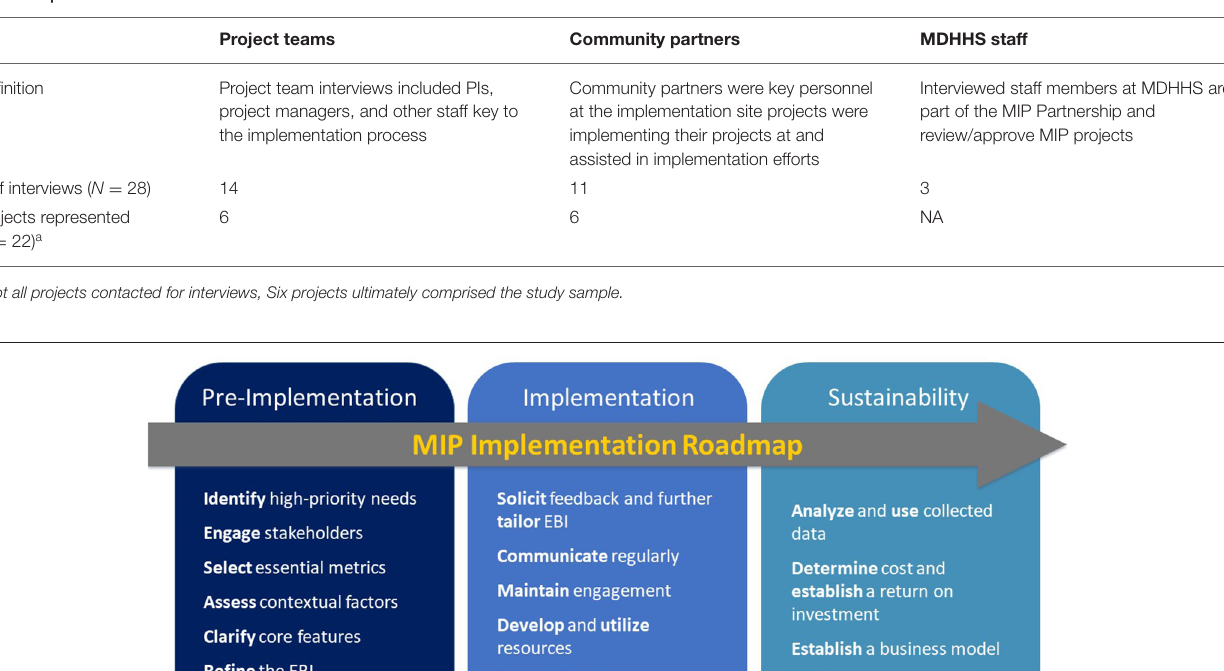
TABLE 2 | Stakeholders interviewed.